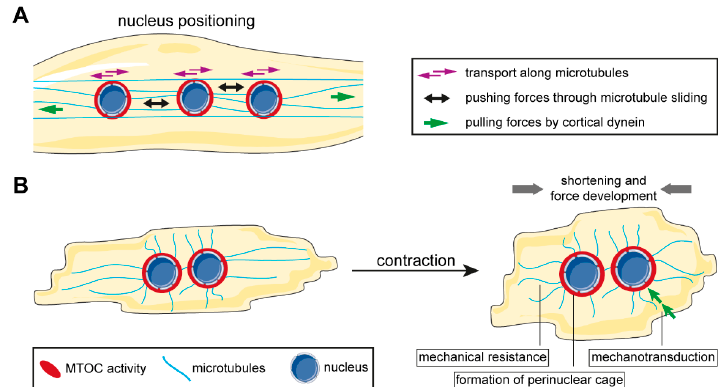
Figure 3. Contribution of the non-centrosomal microtubule-organizing center (ncMTOC) to striated muscle function (see main text for details). ( A ) The nuclear envelope ncMTOC promotes nuclear positioning in various ways. Microtubule-associated motors are recruited to the nuclear envelope to allow nuclear movement in a cargo-like manner along microtubules. Furthermore, perinuclear microtubules enable application of pushing forces through motor-mediated microtubule sliding as well as pulling forces exerted by cortically anchored dynein on the nuclei. ( B ) Microtubules fulfill several functions during muscle contraction. Firstly, stable microtubules modulate contractility by providing mechanical resistance. Secondly, a perinuclear cage consisting of microtubules and MTOC proteins protects nuclear integrity. Thirdly, microtubules link the extracellular space and the contractile apparatus to the nucleus via the linker of nucleoskeleton and cytoskeleton (LINC) complex, which allows transmission of mechanical cues to regulate gene expression.